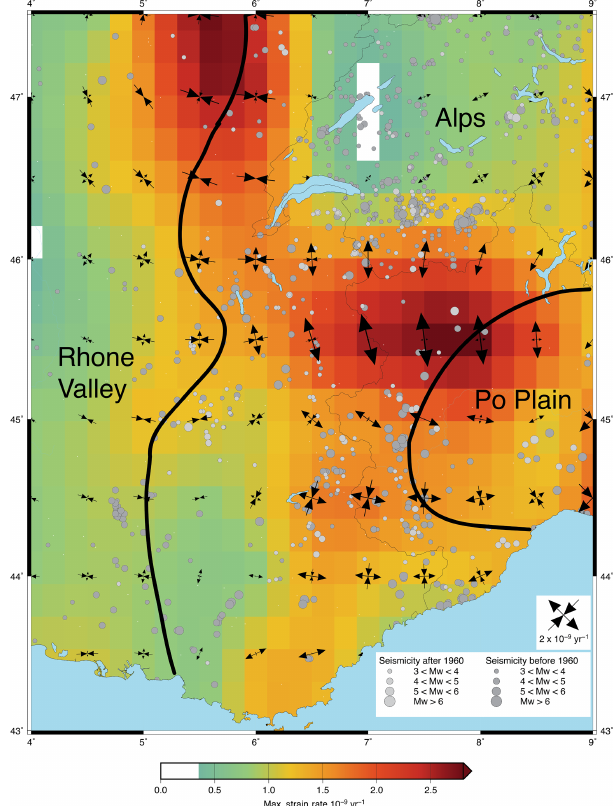
Figure 10. Smoothed horizontal strain rate field for Alpine perma- nent and campaign stations, with instrumental (dark gray) and his- torical (light gray) seismicity (SHARE and SI-Hex) and the limits between Alps and Po Plain and Rhône